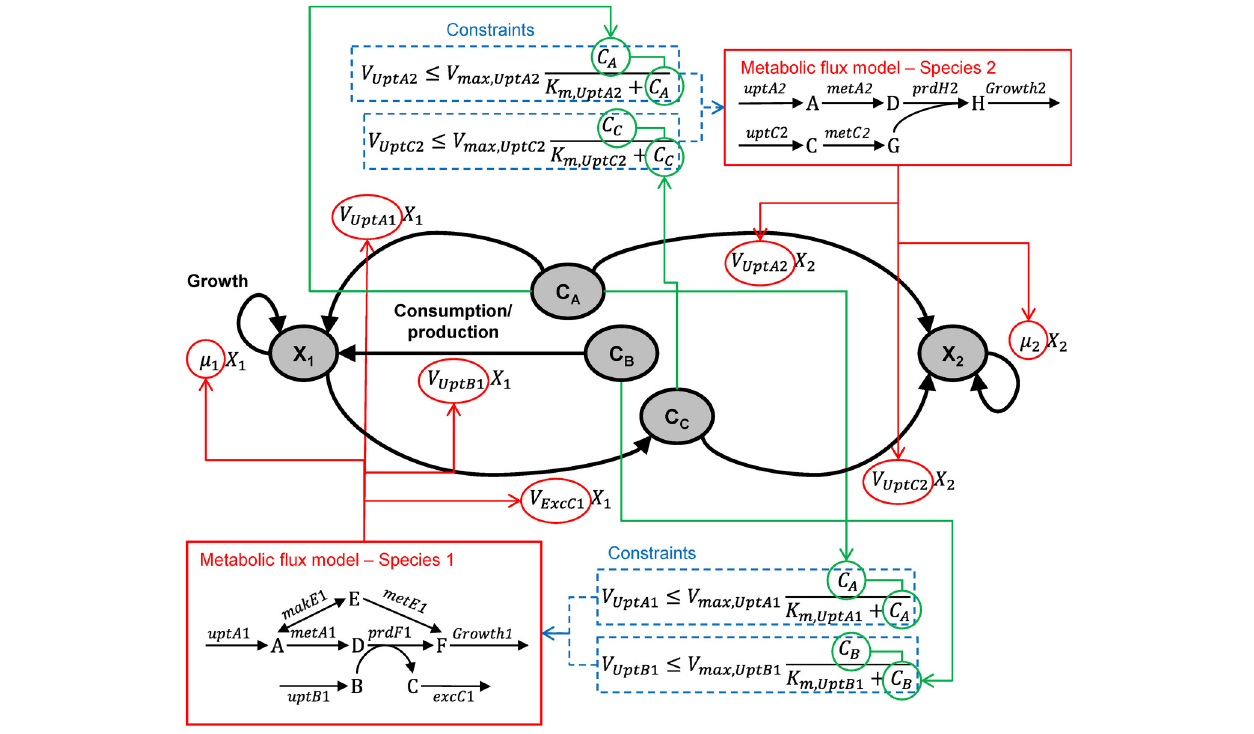
FIGURE B1.1 | Multi-species metabolic flux modeling—environmentally coupled models. After Figure 2 in Zhuang et al. (2011). X (gDW L − 1 ) = microbial biomass concentration, C (mmol L − 1 ) = extracellular metabolite concentrations, µ (h − 1 ) = specific growth rates, V (mmol gDW − 1 h − 1 ) = specific flux velocities.